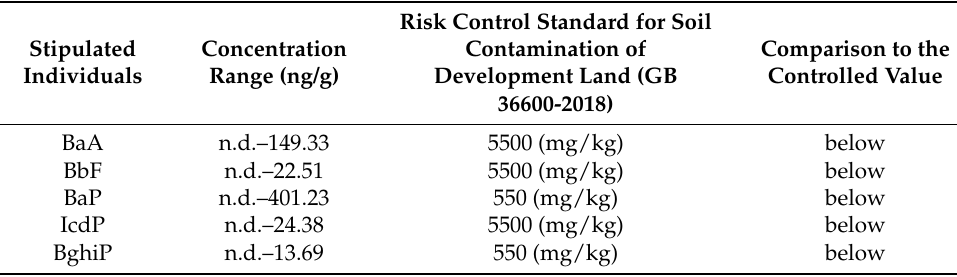
Table 5. Comparison between PAH in the target site and the “Risk control standard for soil contami- nation of development land (GB 36600-2018)”.